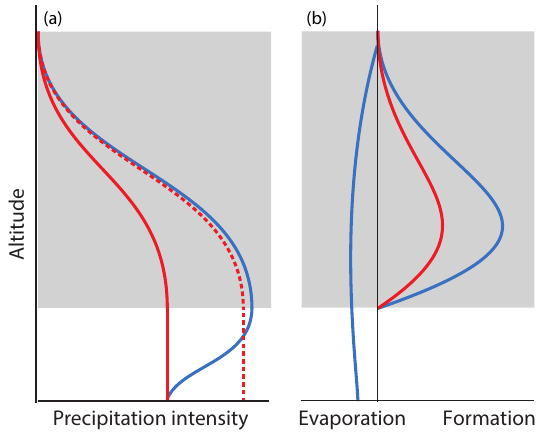
Figure 7. Schematic comparison of (a) precipitation and (b) precip- itation formation (positive) and evaporation (negative). BASE recal- culated (dashed) and rescaled (solid) profiles are shown in red; IFS values used in all other simulations are in blue. The shaded area denotes the vertical cloud